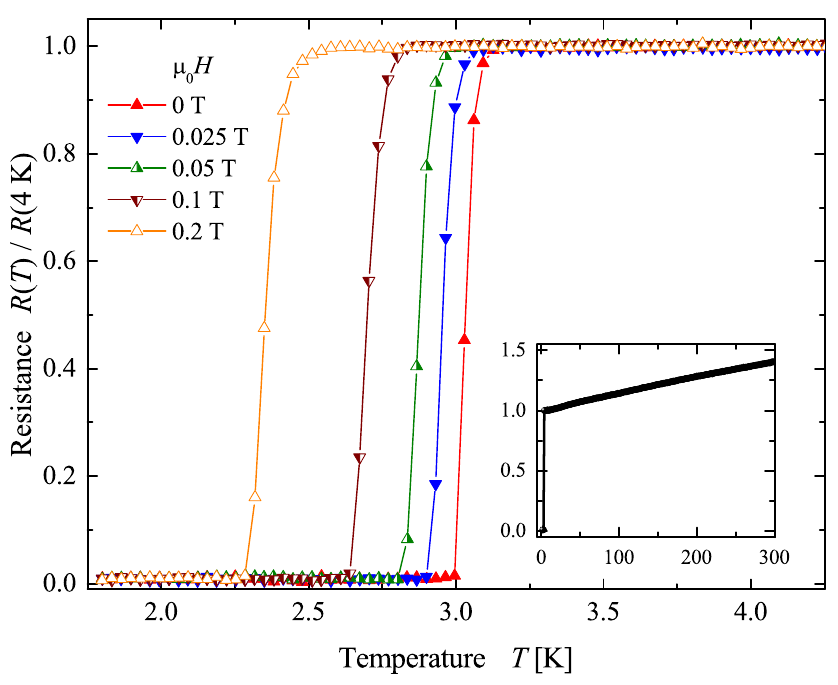
Figure 4. Resistance of AuPdScAl. The figure shows the temperature dependence of the resistance in the T c region, at five different magnetic induction fields µ 0 H . The inset shows the resistance of AuPdScAl for an expanded temperature